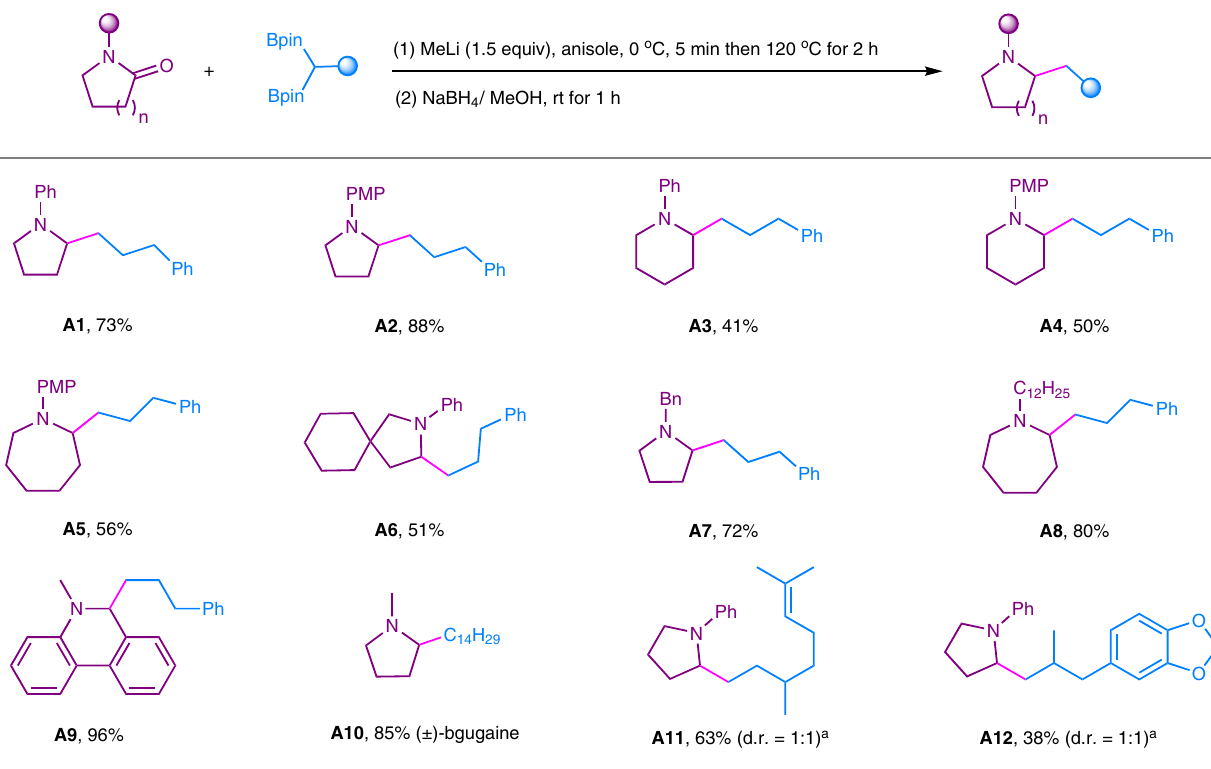
Fig. 9 Deoxygenative alkylation of lactams using 1,1-diborylalkanes. Reaction conditions: 1) tertiary lactam (0.25 mmol), 1,1-diborylalkane (0.375 mmol), MeLi (0.375 mmol), anisole (2.0 mL), 0 °C, 5 min then 120 °C, 2 h; 2) NaBH 4 (0.75 mmol), MeOH (1.0 mL), rt for 1 h. Yields based on isolated products. a The d.r. value was determined by 1 H NMR analysis. PMP: p -methoxyphenyl; Bn: